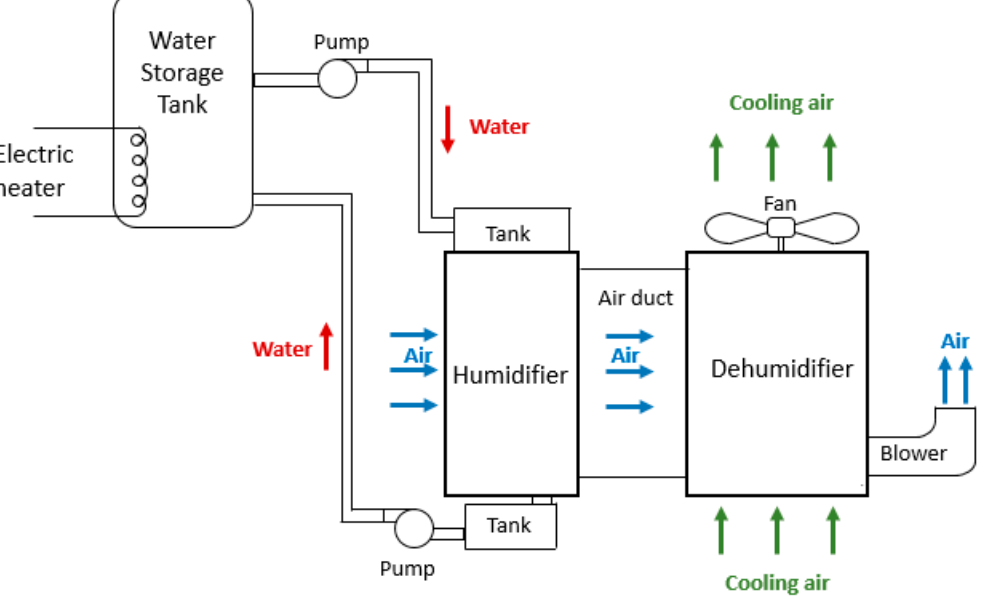
Figure 1. Schematic diagram of experiment setup of the air-cooling humidifier–dehumidifier (HDH) system.